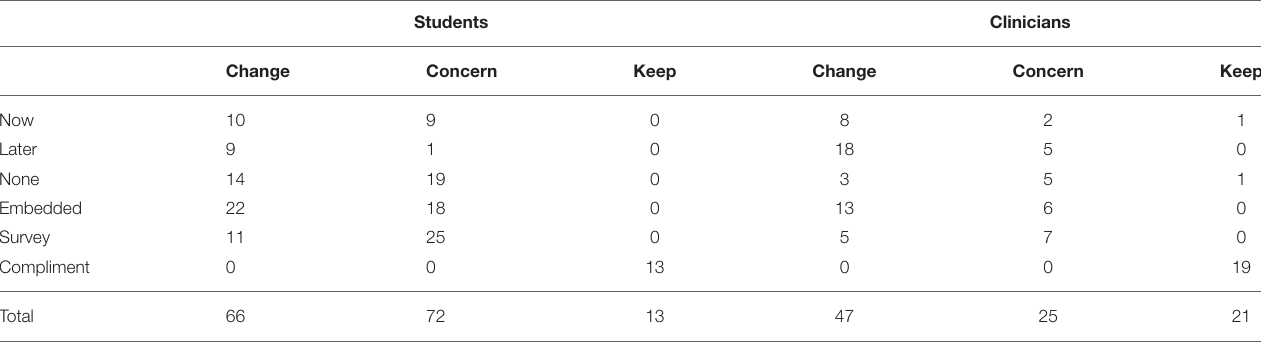
TABLE 2 | Number of changes across undergraduate focus groups and clinician interviews.